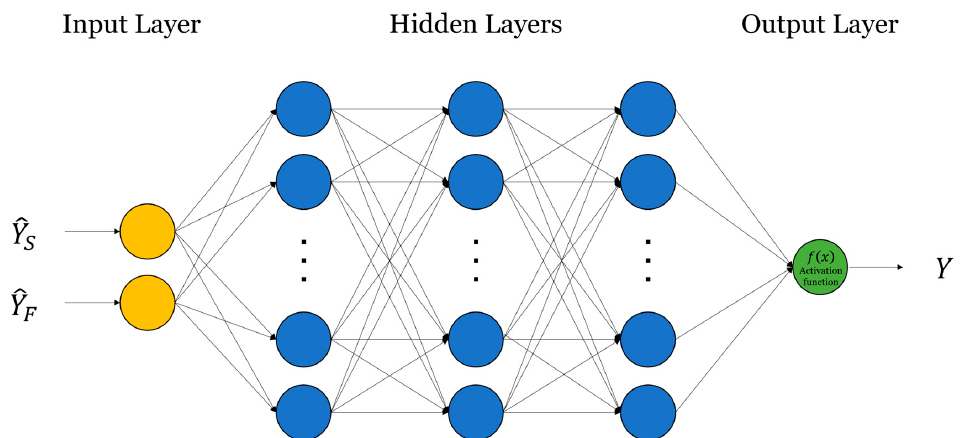
Figure 6. Structure of the domain hybrid day-ahead solar radiation forecasting